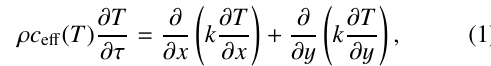
Fig. 3. Parametrization of the interrupted melting process using c e ff –T and h–T dependency, according to Bony and Citherlet [10]